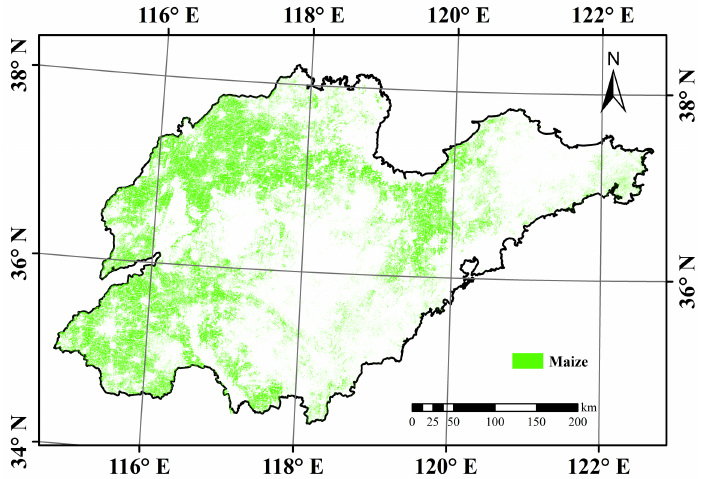
Figure 16. ( a – d ). Estimated area of different models vs. the statistical area. The dotted line in the figure represents the 1:1 line, and the orange line is the estimated data fit line.